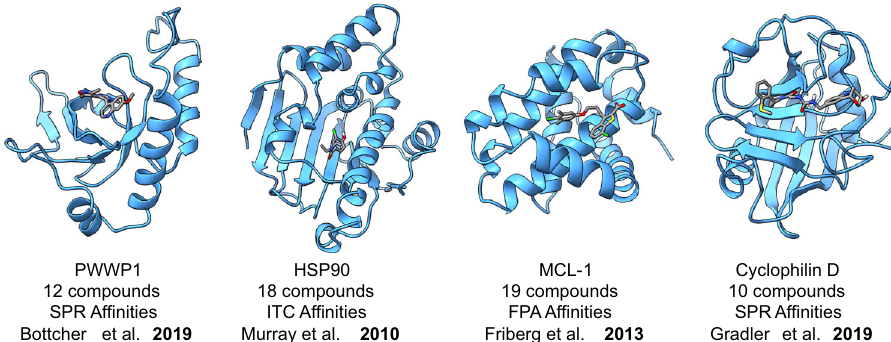
Fig. 1 Overview of the fragment elaboration datasets. A total of 59 ligands from four different elaboration studies 38 – 41 with af fi nities spanning the millimolar to nanomolar range are investigated